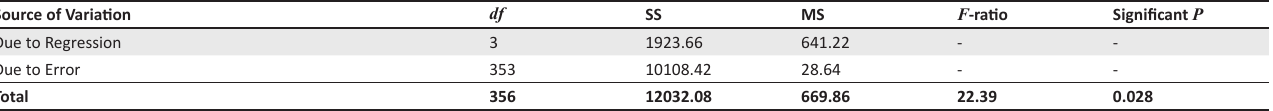
TABLE 6: Summary of multiple-regression analysis of information-seeking behaviour, information utilisation and knowledge sharing on innovation capability of the